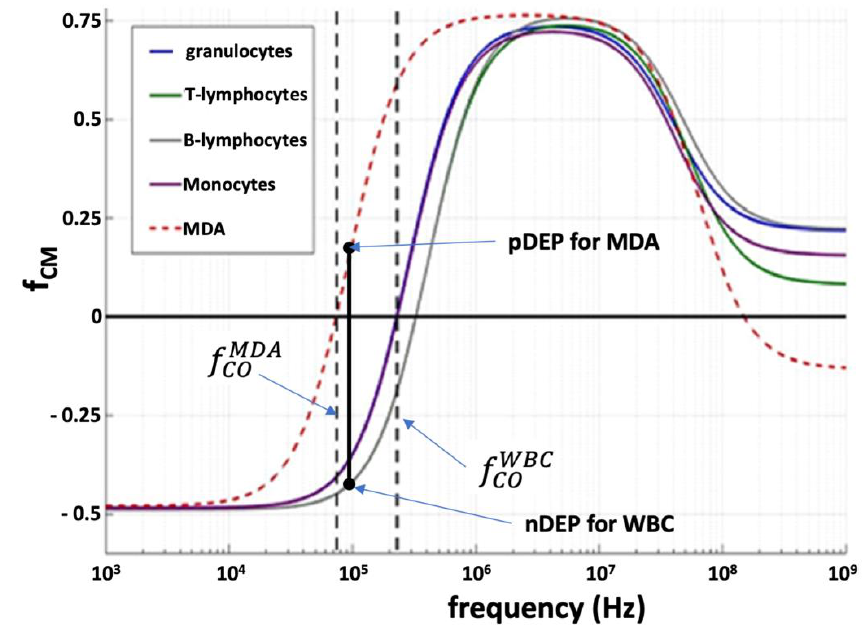
Figure 2. Clauss − Mosotti function for MDA, a CTC derived from breast cancer, as compared to healthy cell types in pheripheral blood.